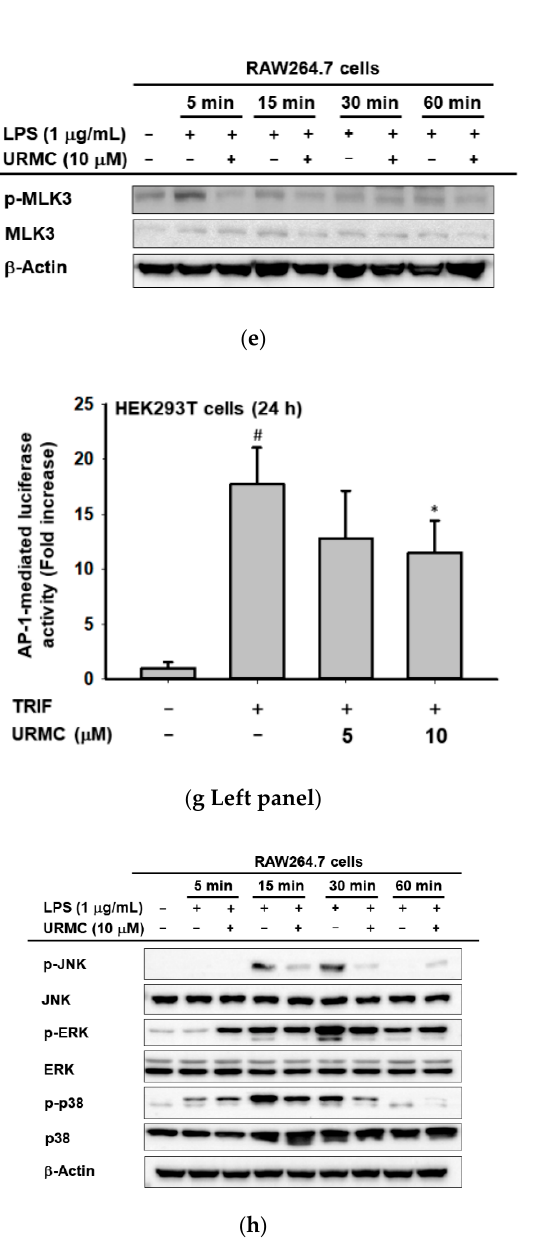
Figure 4. Inhibition of MLK3 reduces inflammatory responses mediated by AP-1 in LPS-activated RAW264.7 cells. ( a ) Chemical structure of URMC-099. ( b ) Viability of RAW264.7 and HEK292 cells under URMC-099 treatment conditions was evaluated by MTT assay. ( c , d ) The mRNA expression levels of COX-2 and CCL-12 were determined by RT-PCR and real-time PCR from RAW264.7 cells stimulated with LPS. ( e , f , h ). The phospho- and total forms of MLK3, c-Jun, JNK, p38, and ERK were detected from whole cell lysates of RAW264.7 cells stimulated with LPS by immunoblotting analysis. ( g ) Luciferase activity mediated by AP-1 in HEK293 cells transfected with AP-1-Luc as well as TRIF or MyD88 in the presence or absence of URMC-099 was determined by luminometer. Results ( b , d , g ) are expressed as mean ± SD. # p < 0.05 and ## p < 0.01 compared to the normal group (no treatment) and * p < 0.05 and ** p < 0.01 compared to the control group (LPS, MyD88, or TRIF alone).